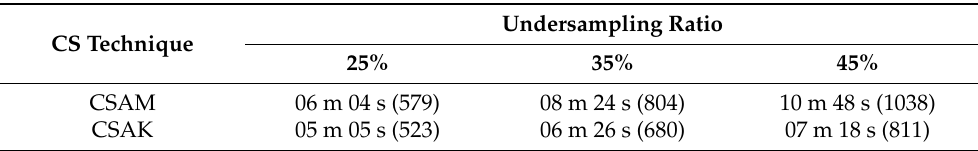
Table 2. Acquisition times for CSA techniques used in brain phantom imaging together with the numbers of phase-encoding lines in parentheses.